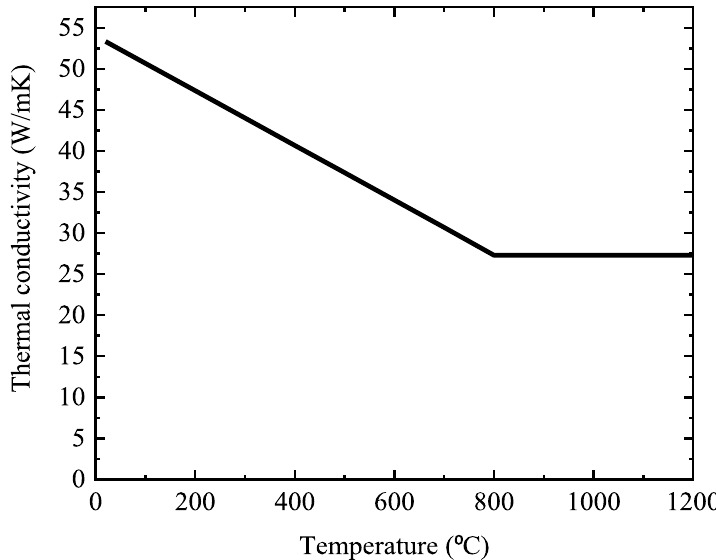
Fig. 20 Thermal conductivity of steel